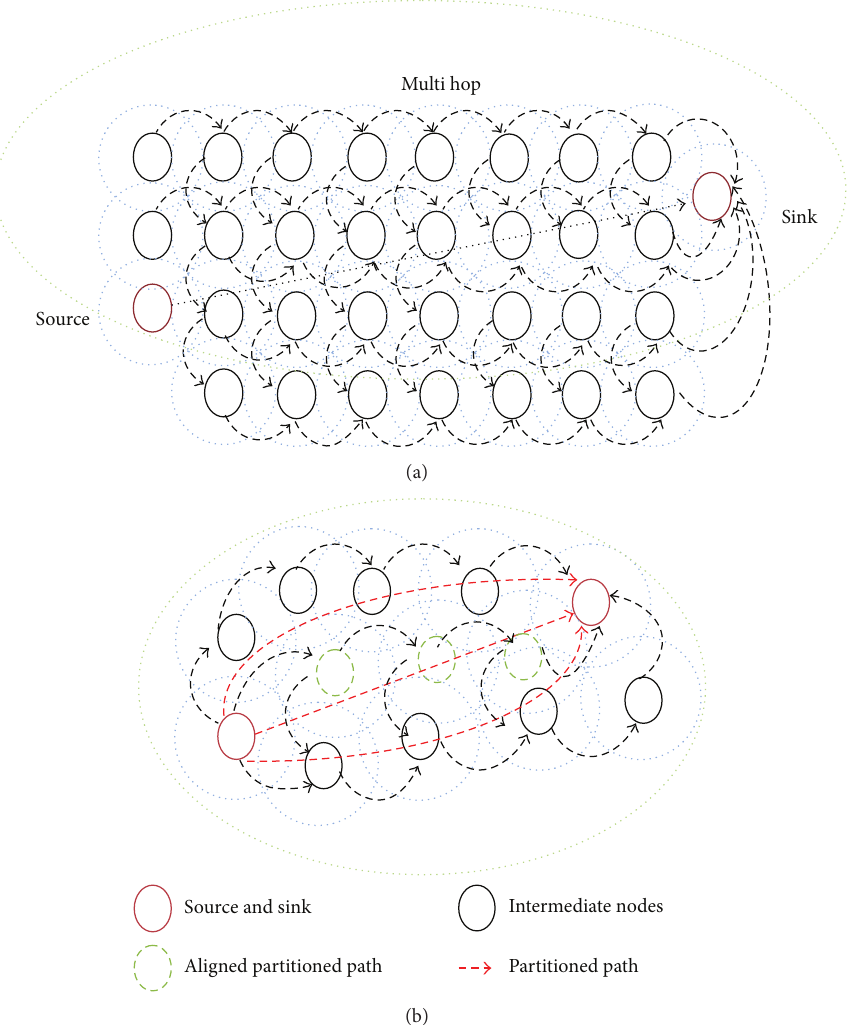
Figure 6: Derivation of the mathematical partitioning model-chain topology. (a) Depiction of the type of distribution of the sensor nodes in the network domain. (b) Magnification of some aligned and nonaligned sensor nodes along the path inside the partition covered area of each path from the source to the